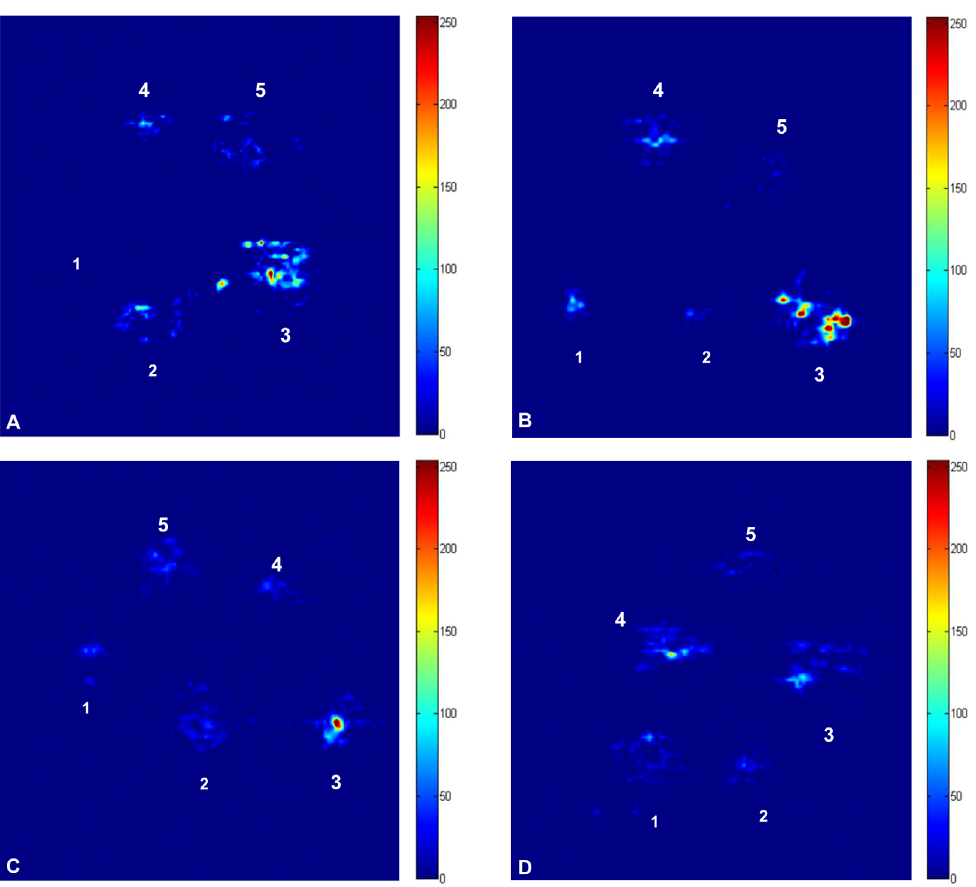
Figure 3. MRI images (transverse slices) of rice root samples immersed in different concentrations of Gd-DTPA for 3 h (A), 6 h (B), 9 h (C) and 12 h (D). In each image, numbers 1 to 5 represent 0 mmol, 2 mmol, 5 mmol, 10 mmol and 15 mmol Gd-DTPA, respectively.